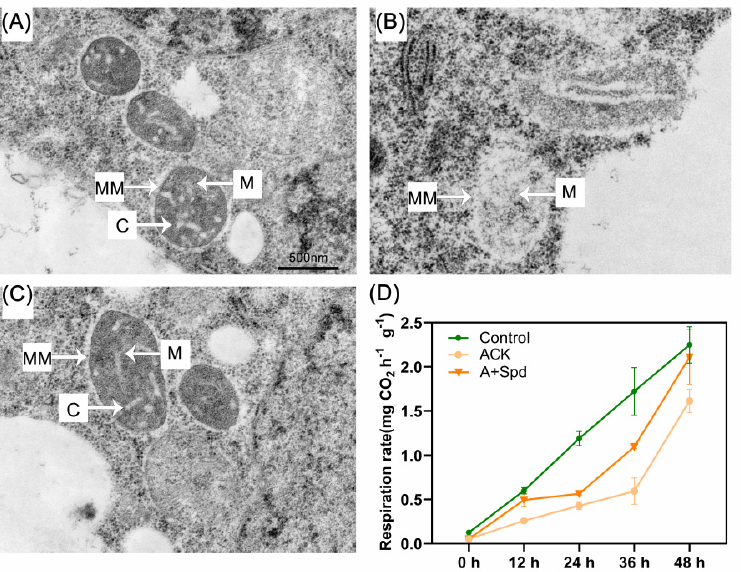
Figure 9. Effects of exogenous Spd on mitochondrial structure and respiration rate during germi- nation in aged embryos. ( A – C ) Electron microscope sections of mitochondria in embryos germi- nated at 36 h under different treatments. ( A ) Control − healthy seeds; ( B ) ACK − artificially aged seeds; ( C ) A+Spd − aged seeds with Spd treatment. Bar = 500 nm, C = cristae, M = mitochondria, MM = mitochondrial membrane. ( D ) Respiration rate analysis of sorghum seeds. Control − healthy seeds; ACK − artificially aged seeds; A+Spd − aged seeds with Spd treatment. The respiration rate of each treatment was measured for seeds at five time points from 0 to 48 h after germination. A 0.05 µ M concentration of exogenous Spd was used.